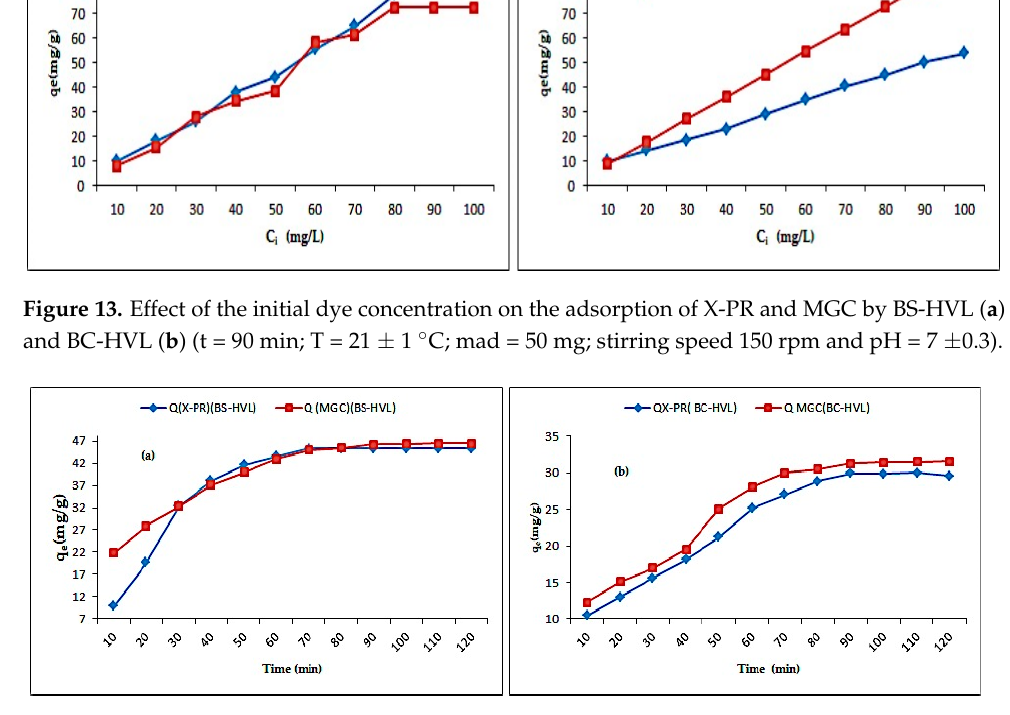
Figure 13. Effect of the initial dye concentration on the adsorption of X-PR and MGC by BS-HVL ( a ) and BC-HVL ( b ) (t = 90 min; T = 21 ± 1 °C; mad = 50 mg; stirring speed 150 rpm and pH = 7 ±0.3).